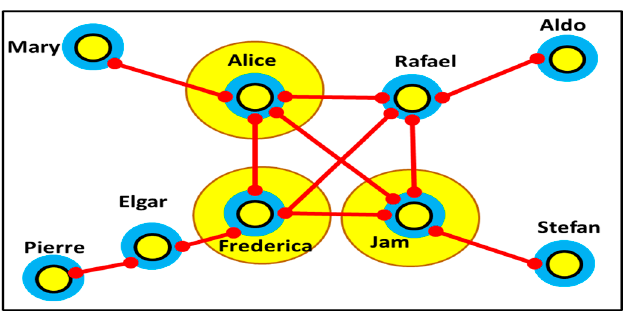
Figure 32. Illustration of the Jordan centrality measure in a SN.